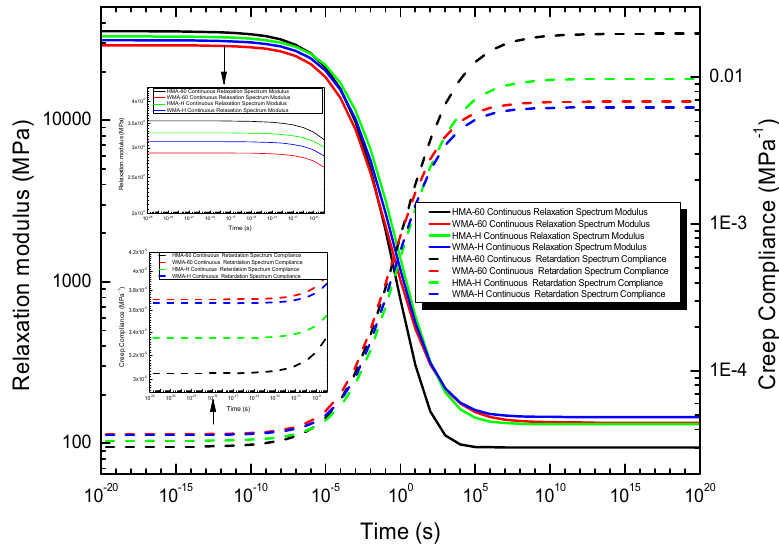
Figure 11. The relaxation modulus and creep compliance obtained from the continuous spectrum.